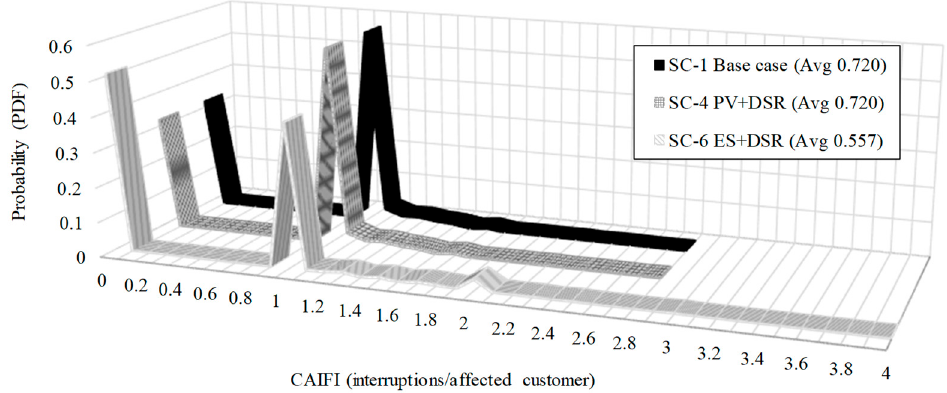
Figure 13. Comparison of PDFs for the CAIFI index.